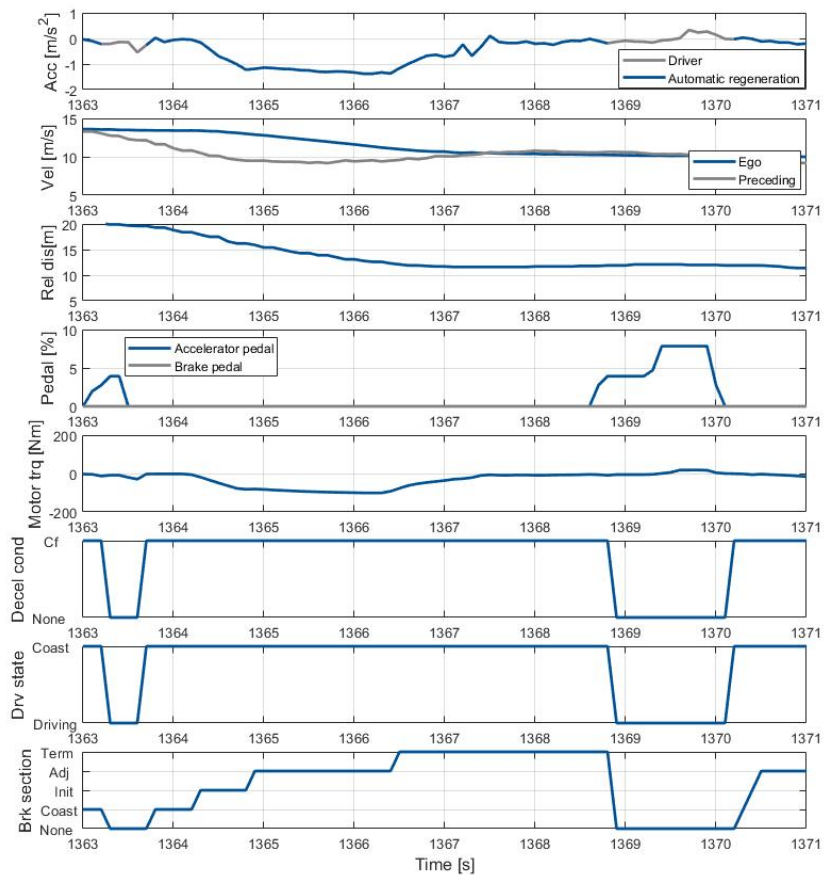
Figure 16. Test results in general car-following situations.